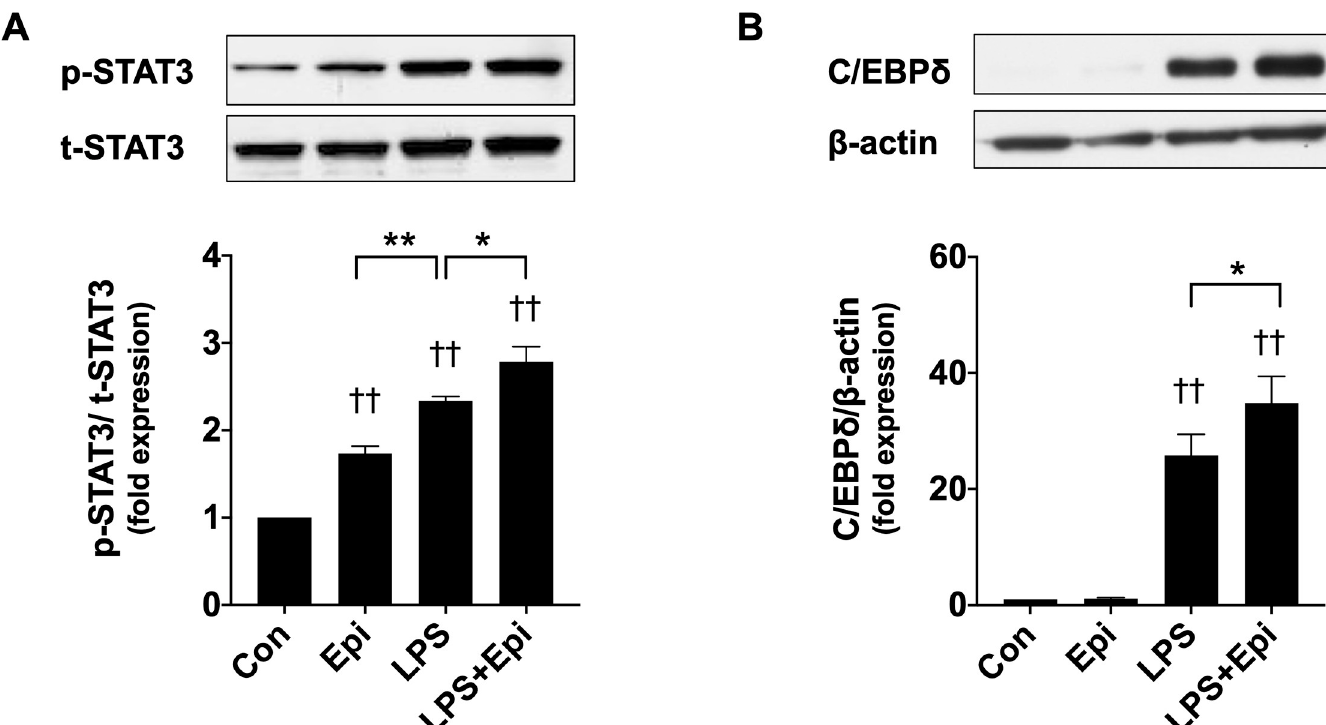
Fig 3. Activation of the STAT3-C/EBP δ pathway by LPS and Epi. C2C12 myotubes were exposed to Epi (1 μ M) and/or LPS (50 ng/ml) for 3 h. Whole-cell lysates were analyzed for p-STAT3, t-STAT3, C/EBP δ , and β -actin protein expressions with immunoblotting analysis. Representative immunoblots are shown. Expressions of p-STAT3 (A) and C/EBP δ (B) proteins were quantified by densitometric analysis, and were normalized to the expression level of t-STAT3 and β -actin, respectively. Fold induction relative to the value of the control condition is presented as mean ± SEM (n = 5). (†P < 0.05 and ††P < 0.005 compared with control, � P < 0.05 and �� P < 0.005 for comparisons between the indicated